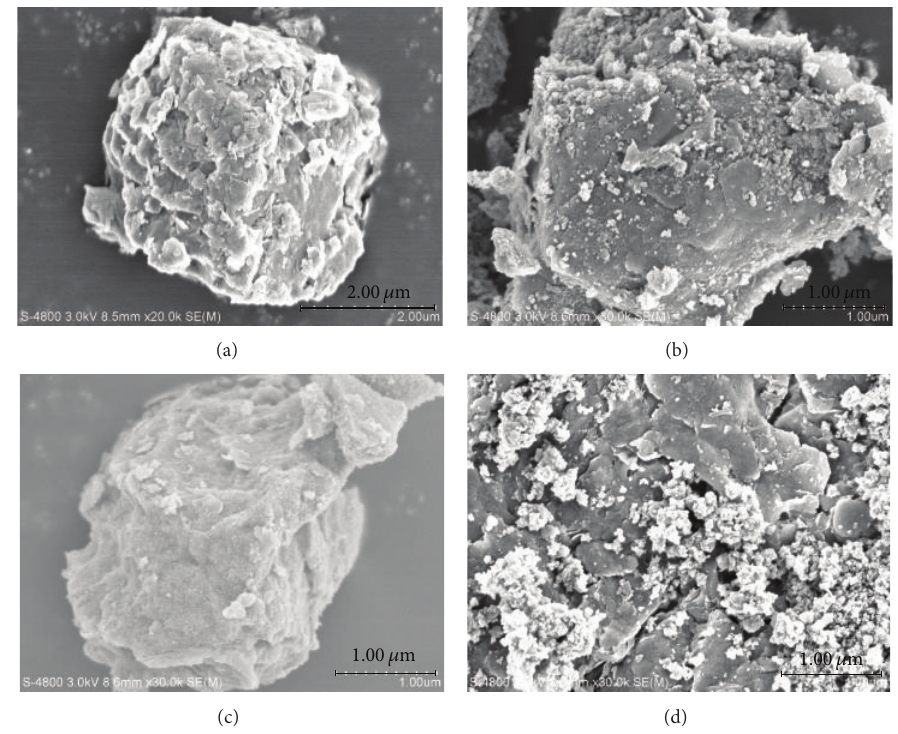
Figure 2: SEM images of (a) bentonite, (b) Fe 3 O 4 -bentonite, (c) TiO 2 -bentonite, and (d) TiO 2 -Fe 3 O 4